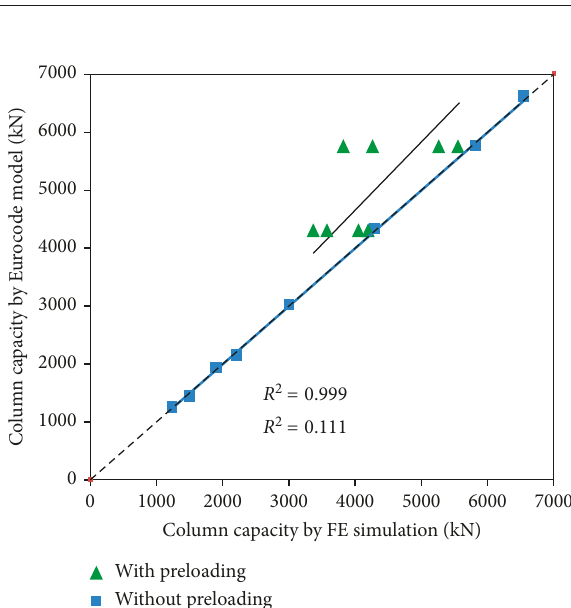
Figure 9: Comparison between the Eurocode model [12] and FE simulation for axial load